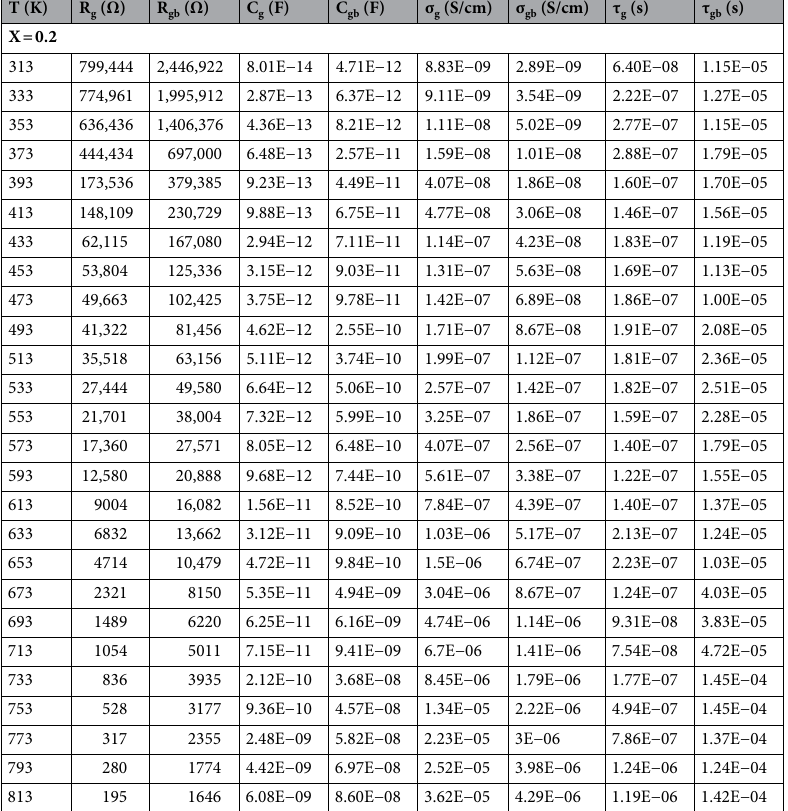
Table 4. Impedance spectroscopy parameters of X = 0.2